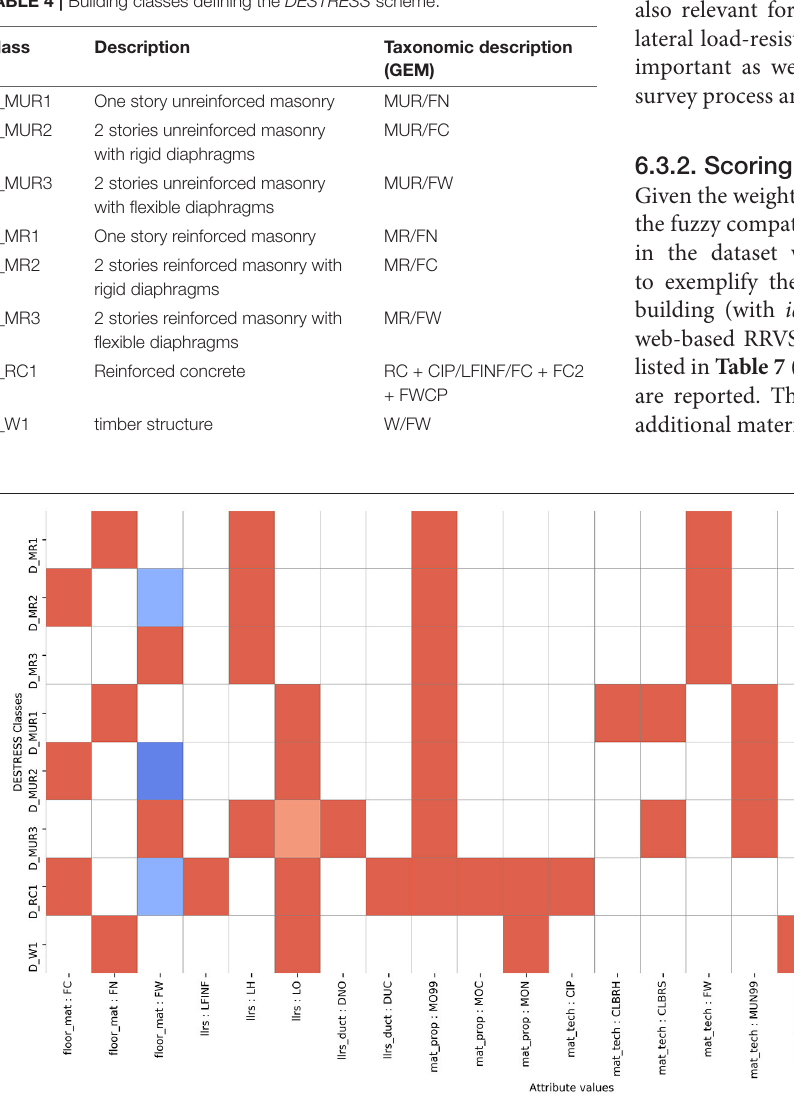
FIGURE 3 | Graphical representation of the class definitions for the DESTRESS scheme. Along the x-axis the considered attribute values; along the y-axis the building typologies defined within the schema. The color encodes the compatibility value, with red indicating high compatibility, blue indicating high incompatibility and gray neutral compatibility. White indicates that no explicit compatibility value has ben assigned (it will be considered as neutral by default).